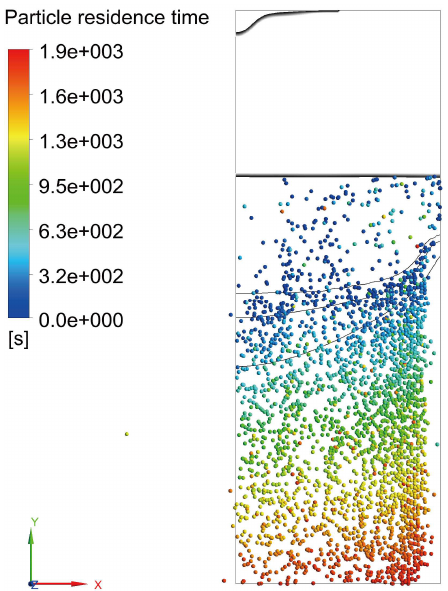
Figure 14. Predicted distribution of inclusions in the metal pool and ingot. Only the inclusions with diameter of 2 μm are displayed.